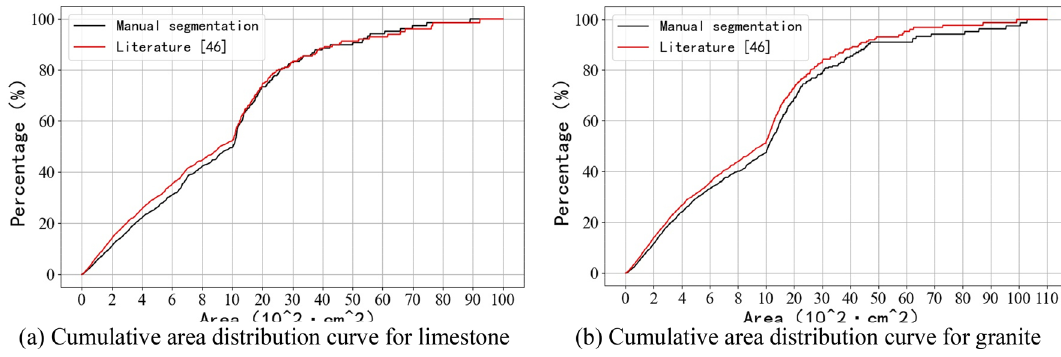
Figure 24. The cumulative area distribution curve for segmentation results in the literature 46